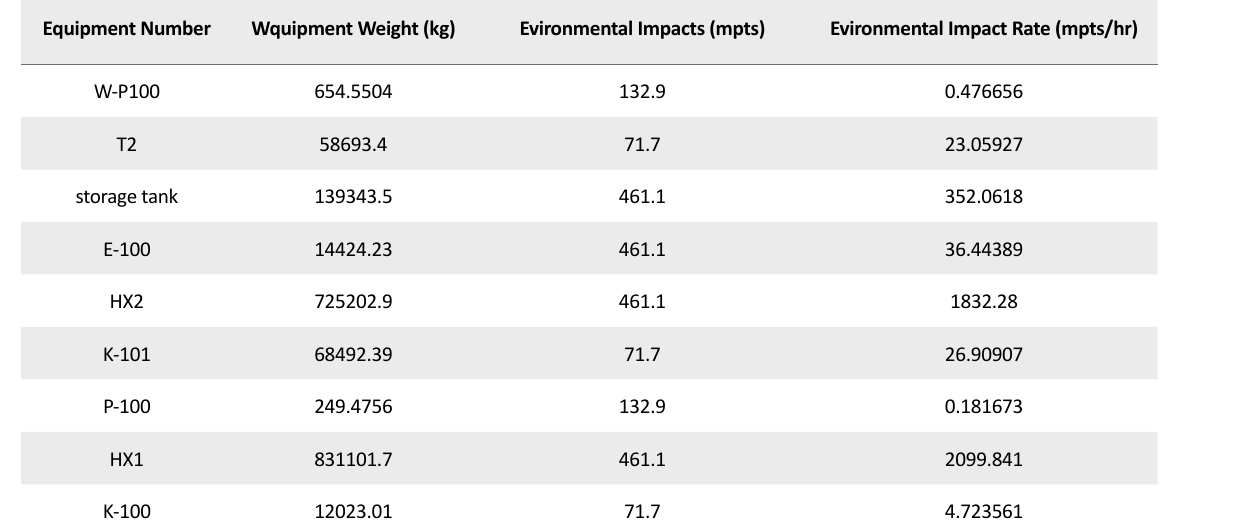
Table 9. Environmental